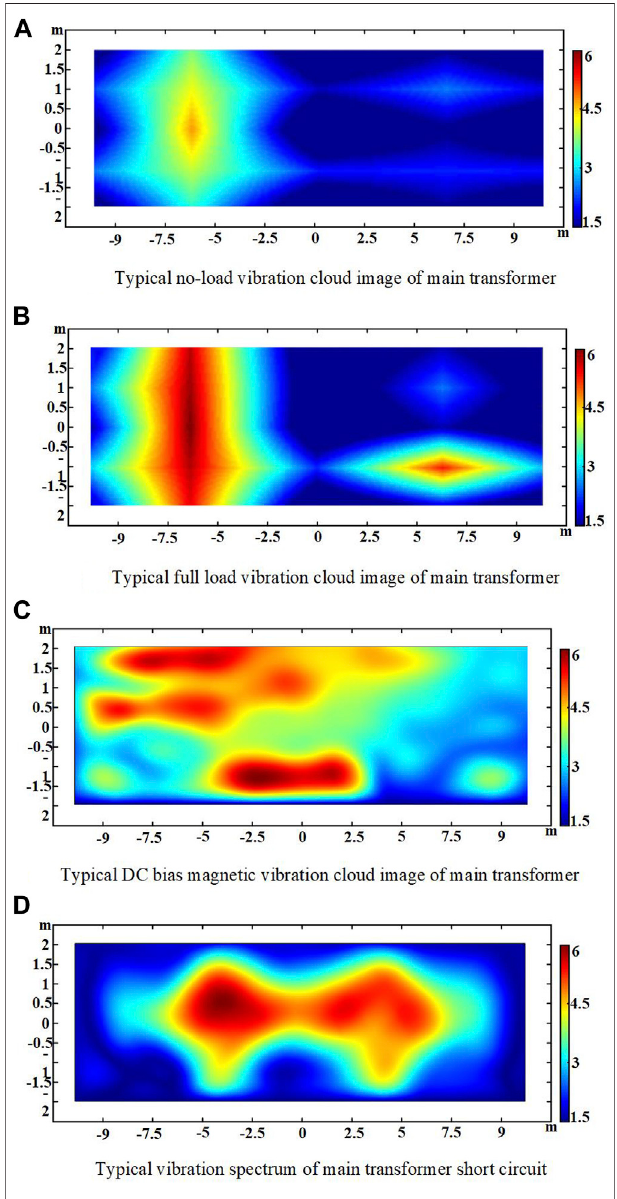
FIGURE 9 | Typical vibration map. (A) Typical no-load vibration cloud image of main transformer. (B) Typical full load vibration cloud image of main transformer. (C) Typical DC bias magnetic vibration cloud image of main transformer. (D) Typical vibration spectrum of main transformer short